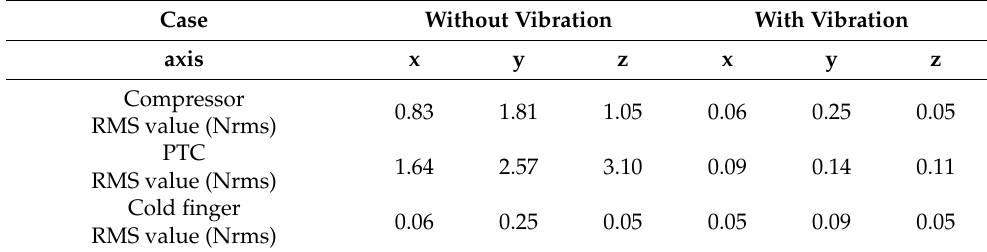
Table 3. Isolation performance test results summary.